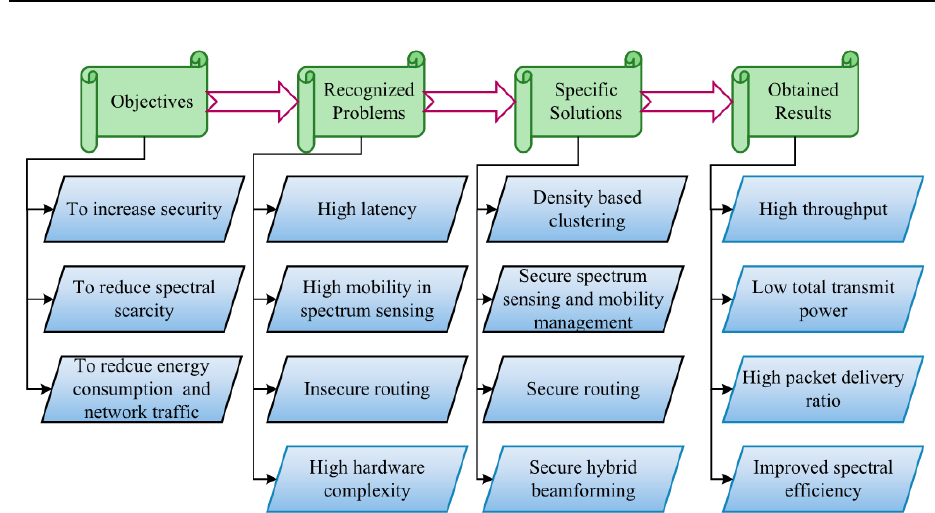
Figure 1. Design reasons for the 6GCRN-IoCV